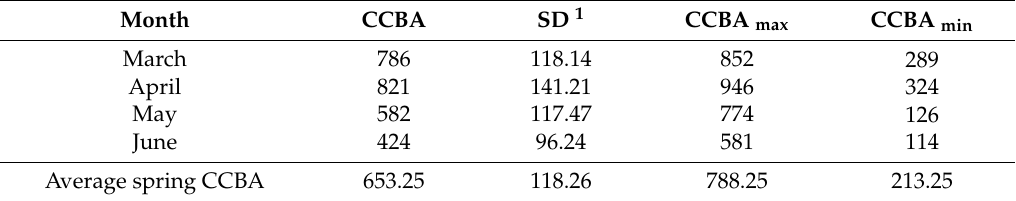
1 SD—Standard deviation.